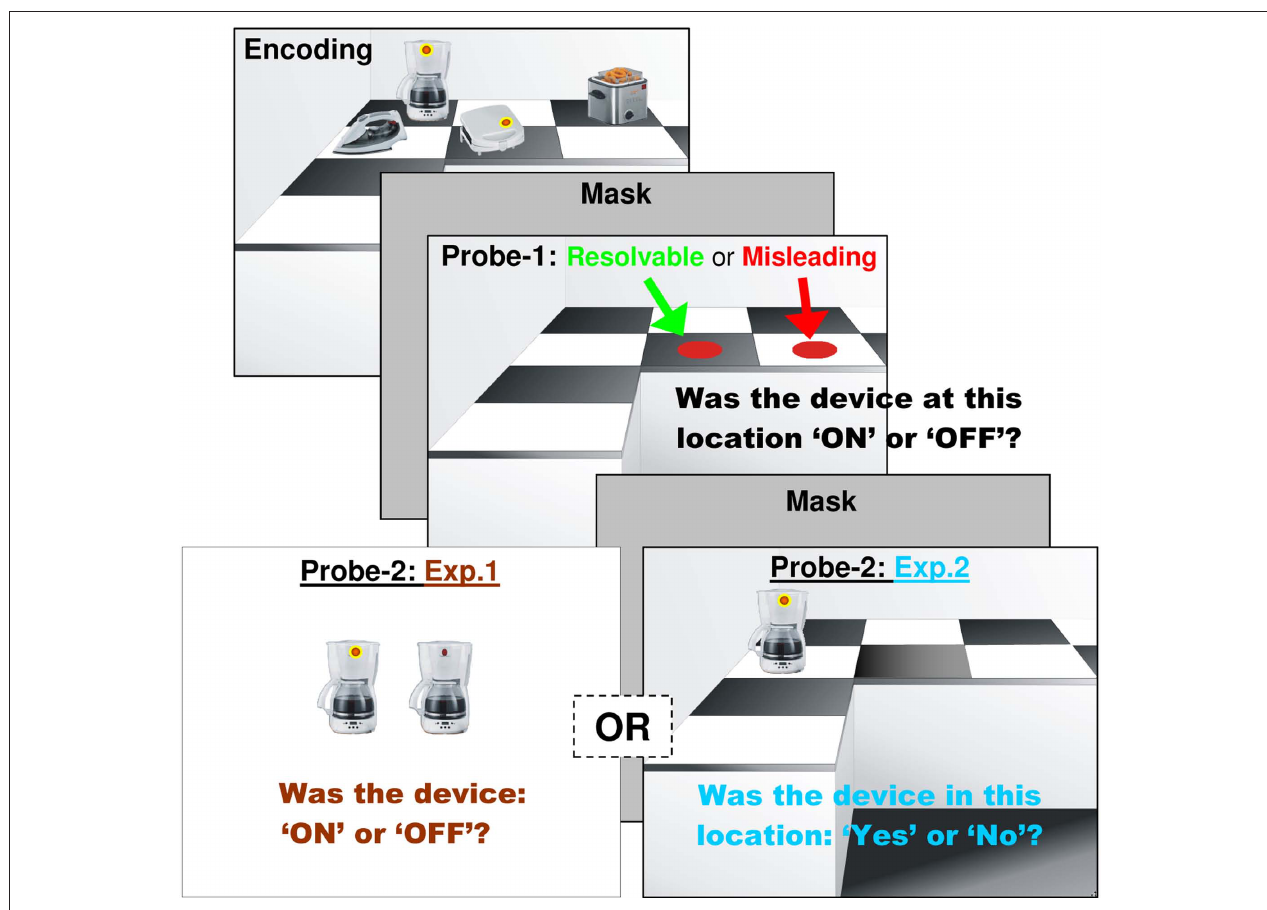
Figure 1 | Procedure and stimuli in experiments 1 and 2. The experiments differed only on probe-2. Please note that appliances were only ever presented in the top 2 (vertical) × 3 (horizontal)